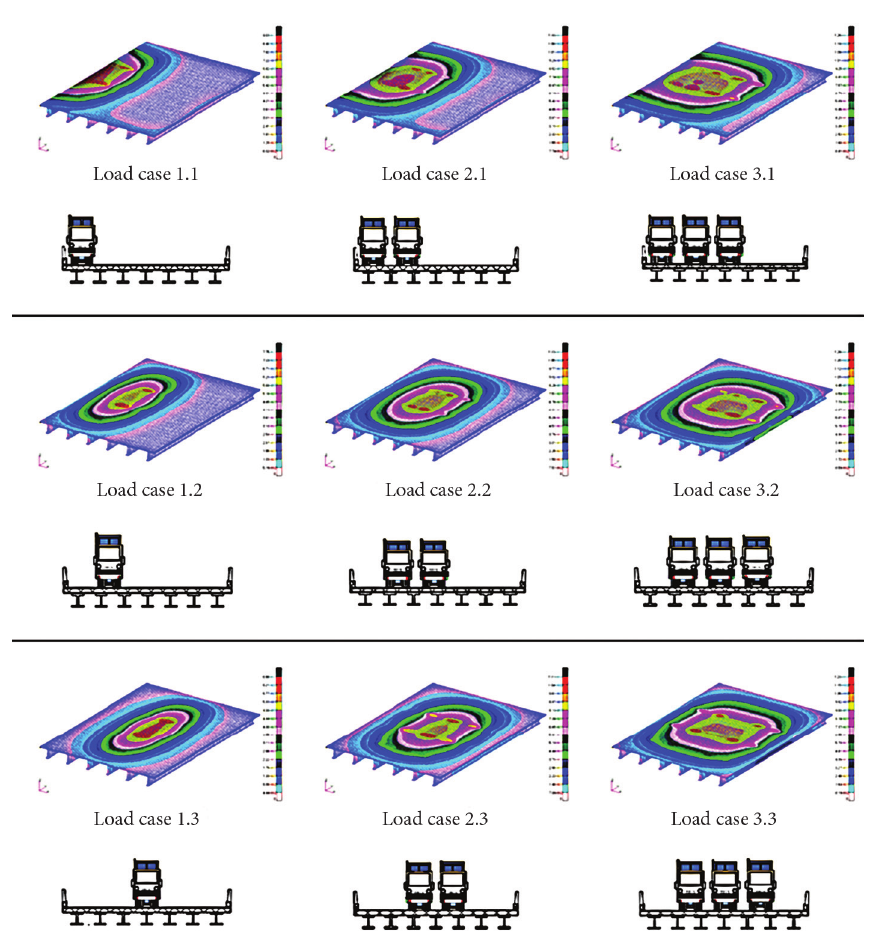
Fig. 5. Finite element models simulated by parametric